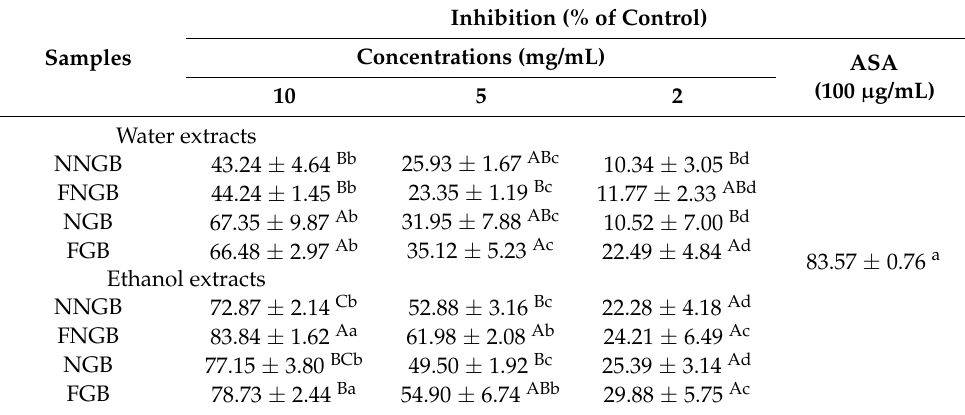
Table 2. Scavenging effects of DPPH radicals by ethanol or water extracts of nonfermented- nongermination black soy milk, fermented-nongermination black soy milk, nonfermented- germination black soy milk, and fermented-germination black soy milk. Inhibition (% of Samples